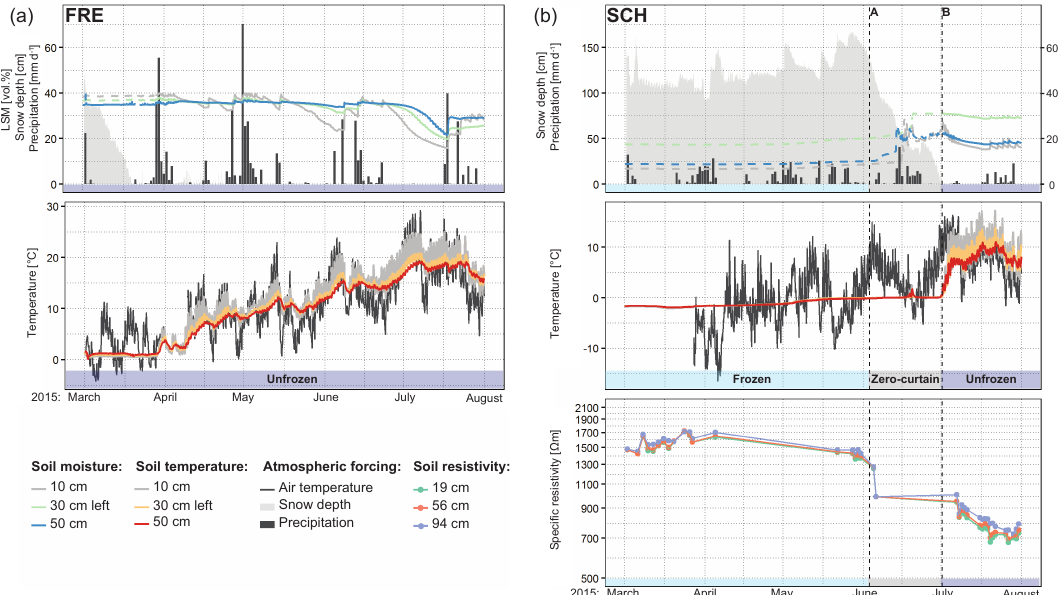
Figure 7. SMT100 measured LSM, ground temperature and soil resistivity at FRE (a) and SCH (b) from March to August 2015. In addition, daily air temperature, snow depth and precipitation sums are shown as well as the date of the transition between the different stages in the thermal evolution at SCH at 10cm (dashed lines A and B; see text for details). The dashed LSM lines represent the soil moisture measurements taken when the ground temperature was below 1 ◦